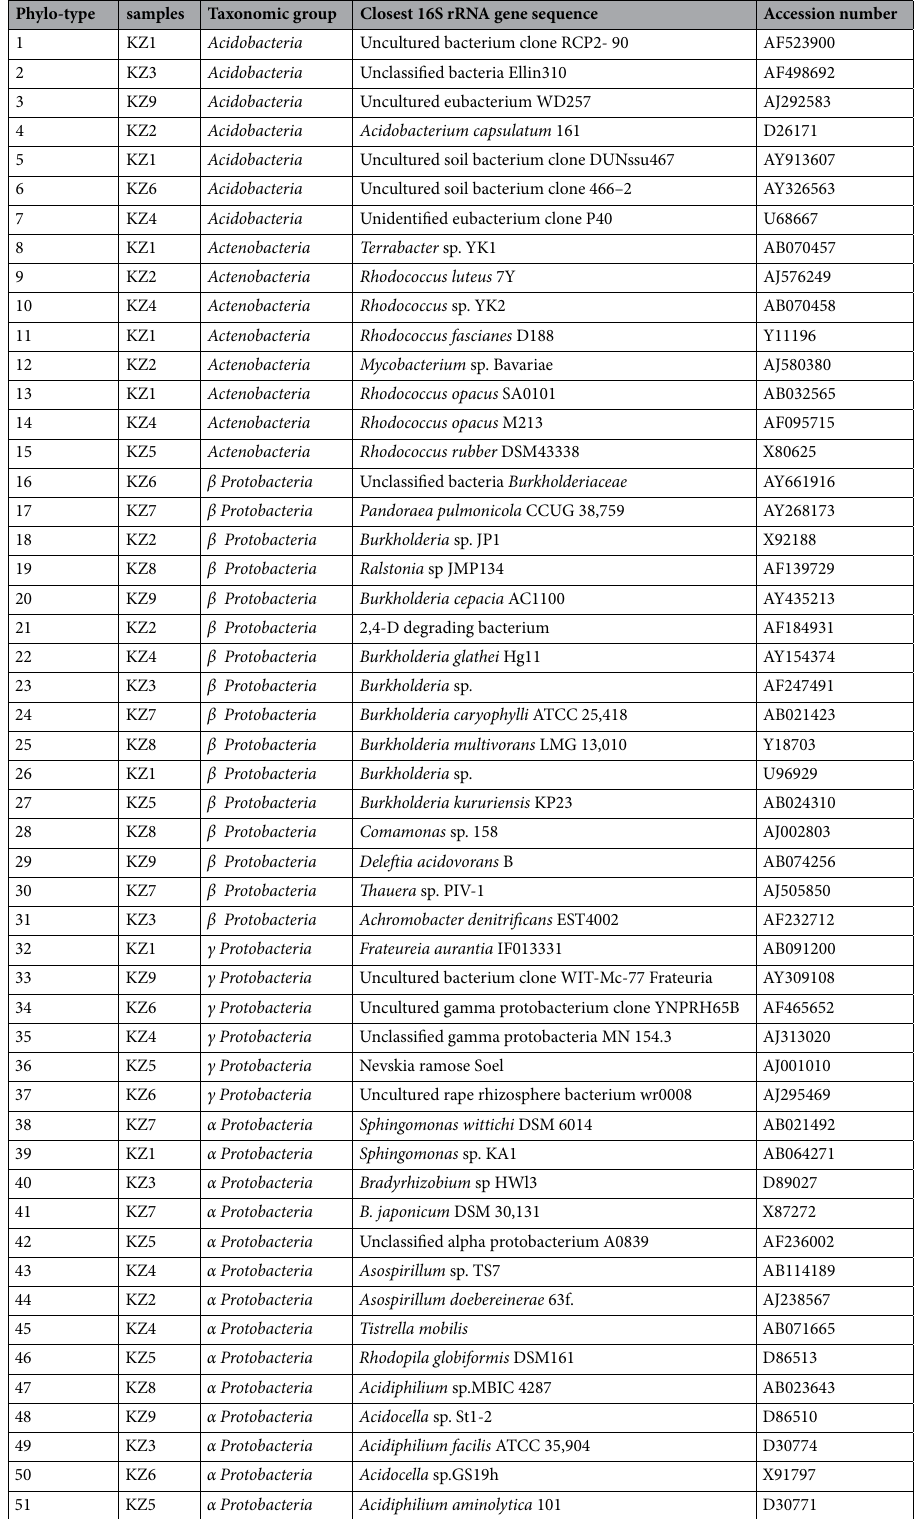
Table 1. Taxonomic identification of single phylotypes found in the DNA-based SSCP fingerprints shown in Supplementary Fig. S1A.